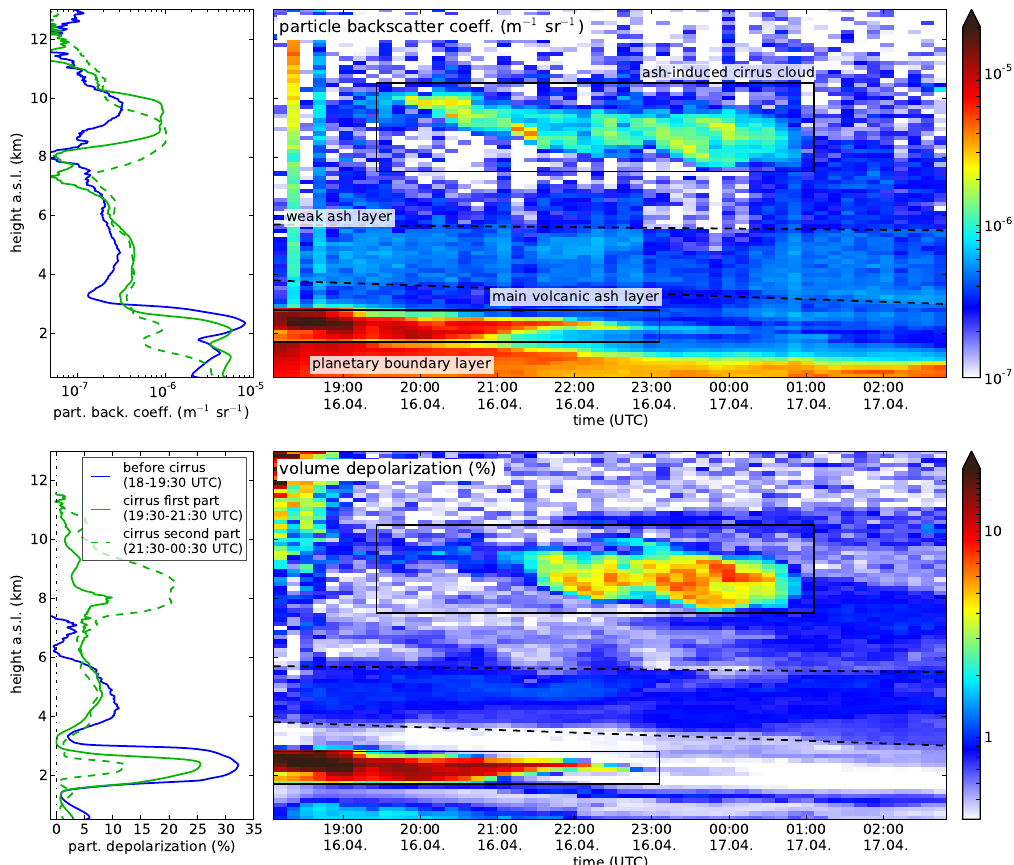
Fig. 1. Particle backscatter coefficient (assuming a lidar ratio of 25 sr) and volume depolarization measured with backscatter lidar Leo-Lidar on 16–17 April 2010 (18:00–03:00UTC) averaged over 5min of data. Three layers of particles are visible: the main volcanic ash layer between 1.6–3.0km, a second weak layer in 4–5.5km, and a layer in the 8–10km region, which includes a cirrus cloud. In addition, profiles of backscatter coefficient and particle depolarization are shown in the left panels obtained from averaged data before cirrus occurrence (18:00–19:30UTC, lidar ratio of 60sr) and two profiles of the first (19:30–21:30UTC) and second (21:30–00:30UTC) part of the induced cirrus cloud (lidar ratio 25